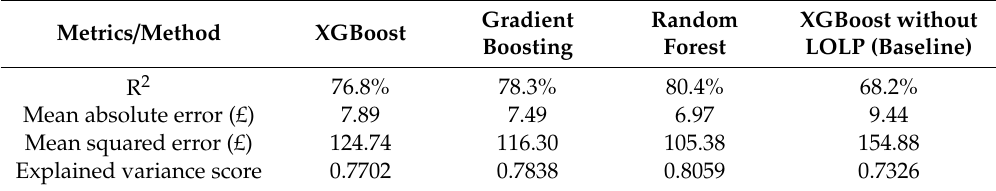
Table 3. Model performance comparison between methods.